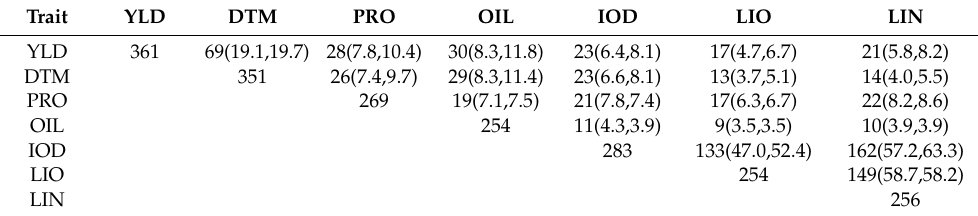
Table 4. Prediction accuracy ( r ± s ) of seven traits using all single nucleotide polymorphisms (SNPs) and different combinations of quantitative trait loci (QTL) identified by different combinations of statistical models. GBLUP was used to estimate r values. Traits